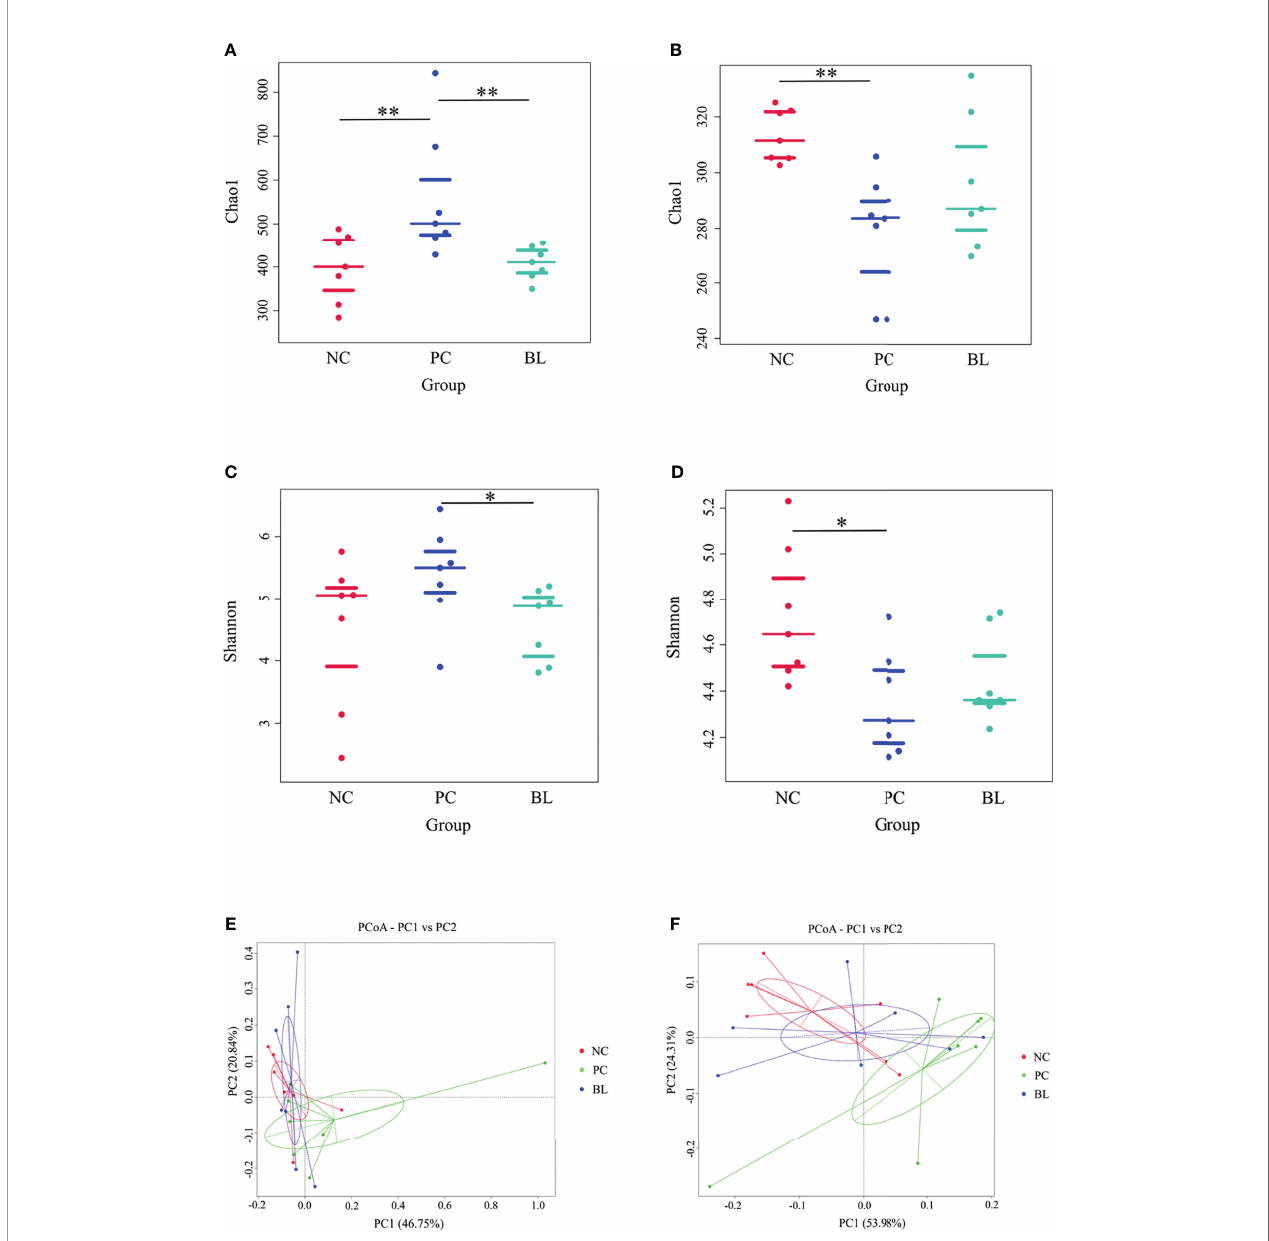
FIGURE 8 | Bacterial alpha diversity and principal-coordinate analysis (PCoA) in the ileum (A, C, E) and cecum (B, D, F) . * P < 0.05, ** P <